Question: What caption would you write for this figure?
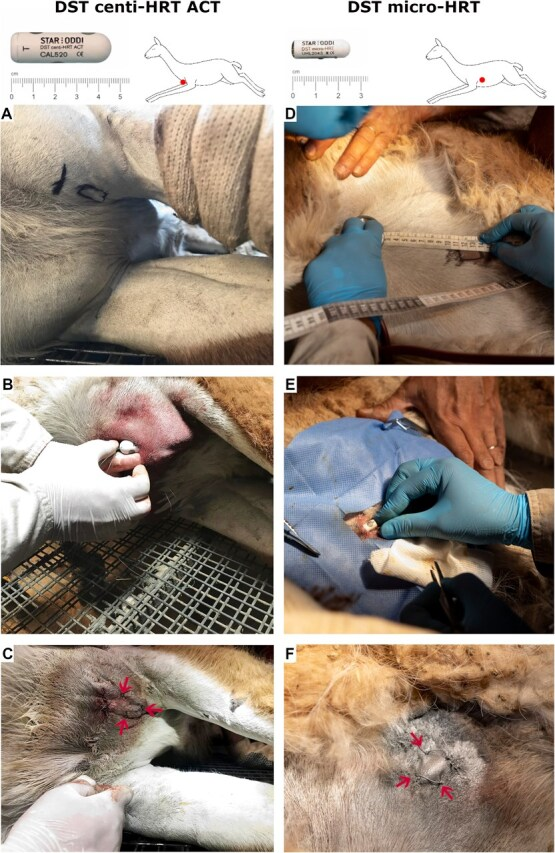
Answer: Orientation and placement of the loggers in guanacos. Dots in the guanaco silhouettes at the top of the figure indicate loggers’ implantation site. (A–C) DST centi-HRT ACT loggers were placed on the pre-sternal region on the left side of the pectoral area. (D–F) DST micro-HRT loggers were placed on the left intercostal region. Arrows in photos C and F indicate stitches around the logger to make a three-sided pocket. Logger photos with the scales are adapted from https://www.star-oddi.com/